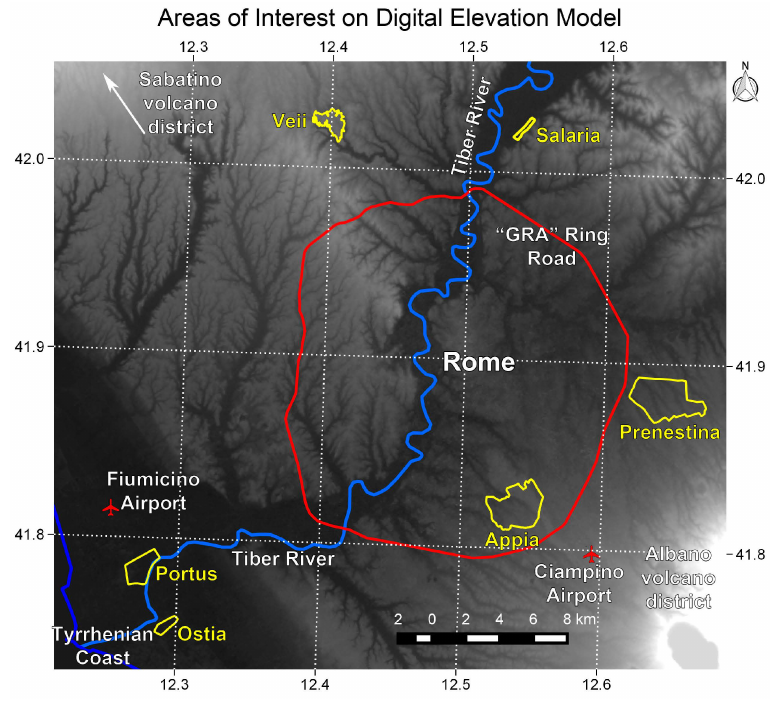
Figure 4. Shuttle Radar Topography Mission (SRTM) Digital Elevation Model (DEM) at a spatial resolution of 1 arc-second (30 m) with AOIs (yellow polygons) overlain. SRTM data courtesy of the United States Geological Survey (USGS,